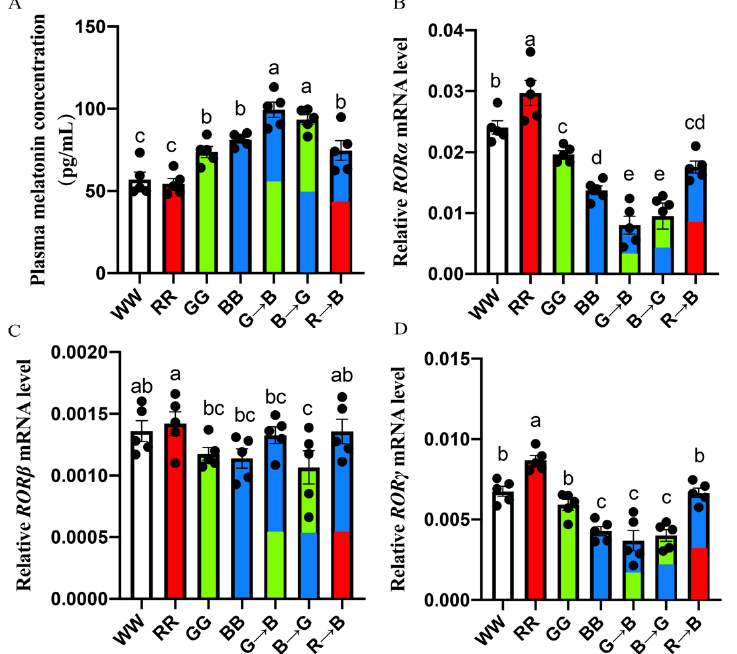
Figure 3. Plasma melatonin concentration ( A ), ROR α mRNA level ( B ), ROR β mRNA level ( C ), ROR γ mRNA level ( D ) in the bursa at P42. The results of each group were expressed as the mean ± standard error. Differences between seven light treatment groups were evaluated by one-way ANOVA, and values with no common letters differ significantly ( p < 0.05).